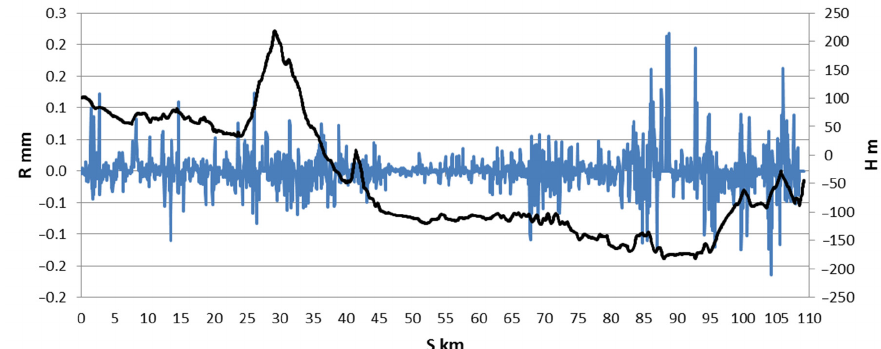
Figure 3. Refraction correction calculated for every set-up in back leveling in blue and cross section of the leveling line in black